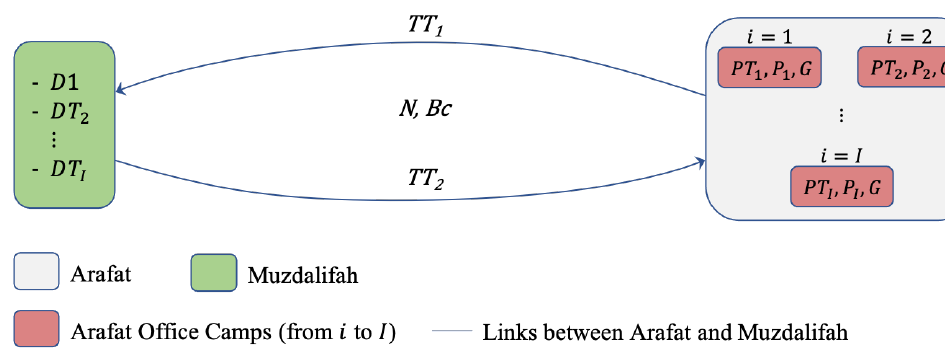
Figure 3. Arafat-Muzdalifah shuttle bus service